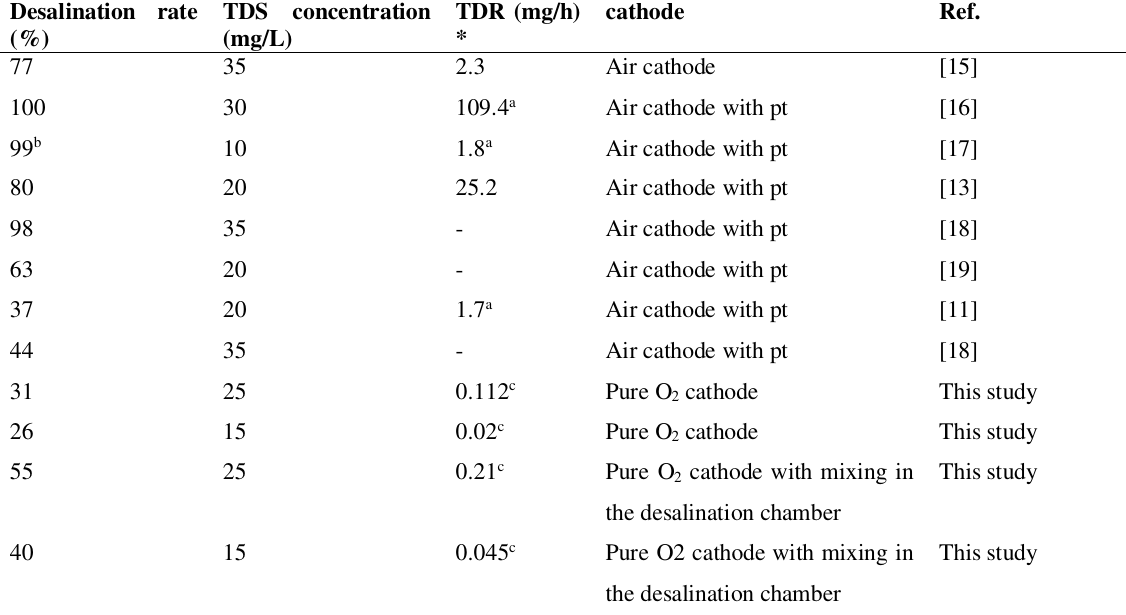
Comparing the performance of microbial desalination cell (MDC).